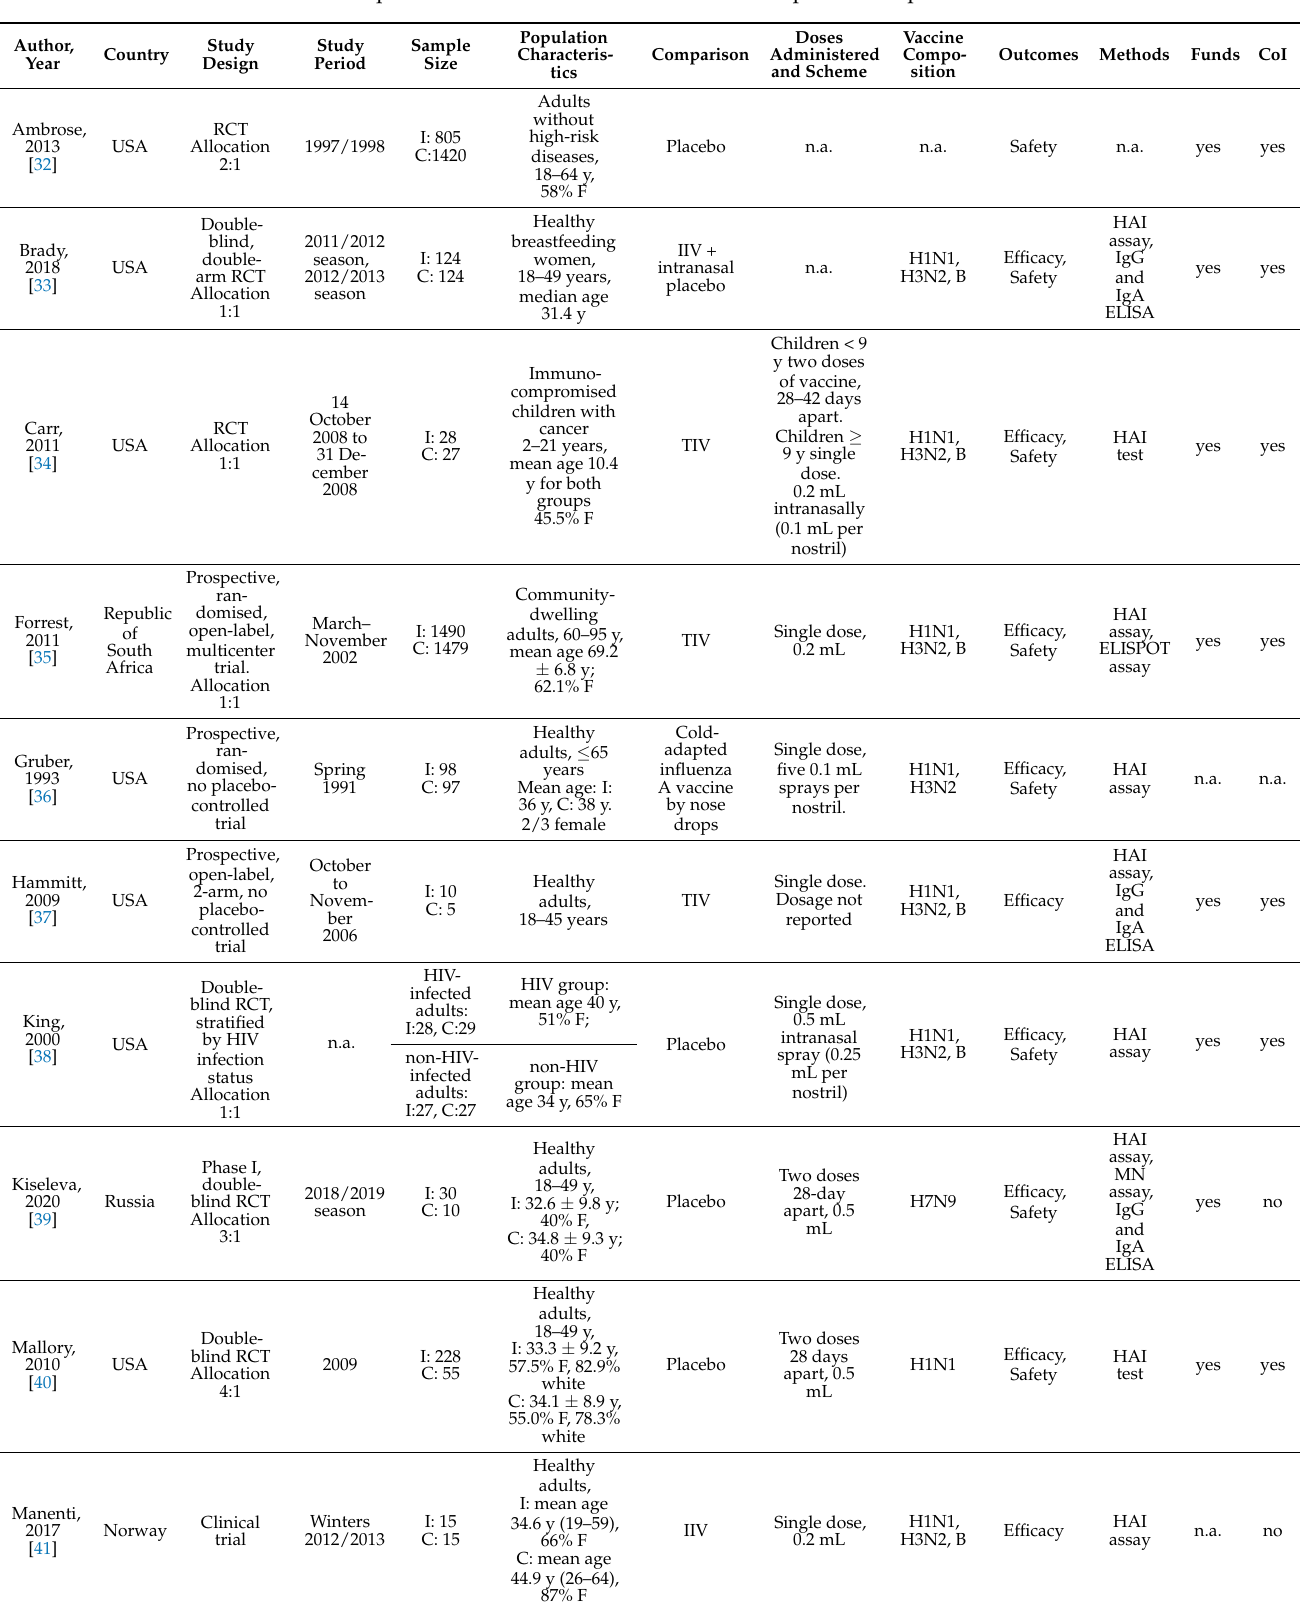
Table 1. Descriptive characteristics of included studies reported in alphabetical